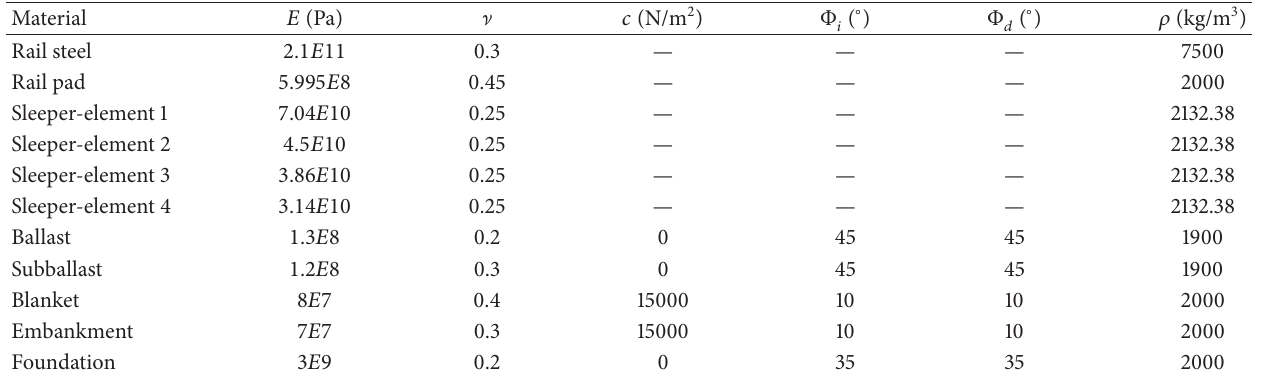
Table 5: Material